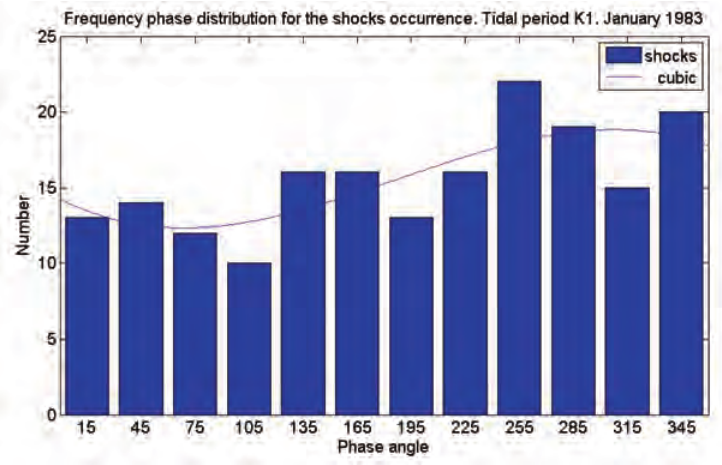
Figure 11. Cumulative histogram corresponding to the tidal period K1 of the 186 events that occurred during January 1983 in the area of